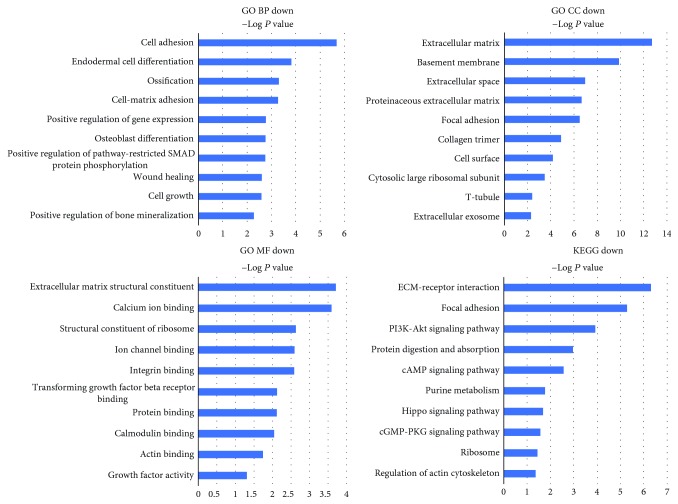
Go functional and KEGG pathway enrichment analysis of downregulated genes. Top 5 most significantly enriched GO terms and KEGG pathways of downregulated genes. The length of the bars on the x-axis represents the negative logarithm of the P value (-log10 P) of each pathway; higher (-log10 P) values indicate a higher significance, and lower (-log10 P) values indicate a lower significance. The GO terms and KEGG pathway names are shown on the y-axis. GO MF DOWN, GO CC DOWN, and GO BP DOWN refer to GO terms enriched by downregulated genes. KEGG DOWN refers to the KEGG terms enriched by downregulated genes.